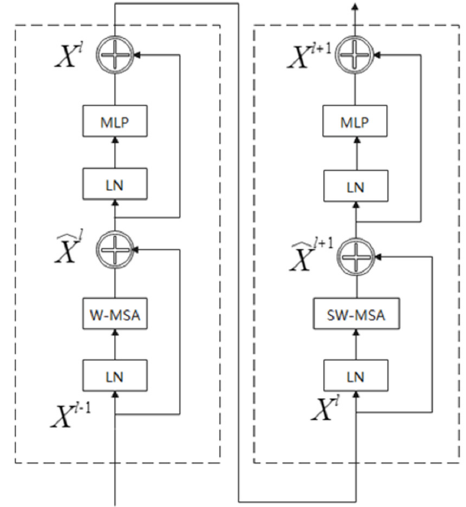
Figure 3. Backbone network of Swin Transformer.